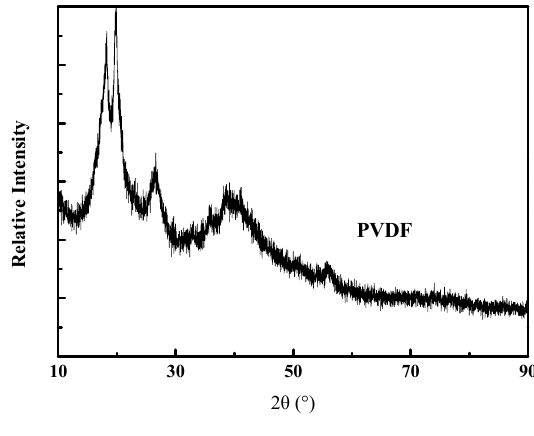
Table 1. Physical and chemical properties of PVDF.